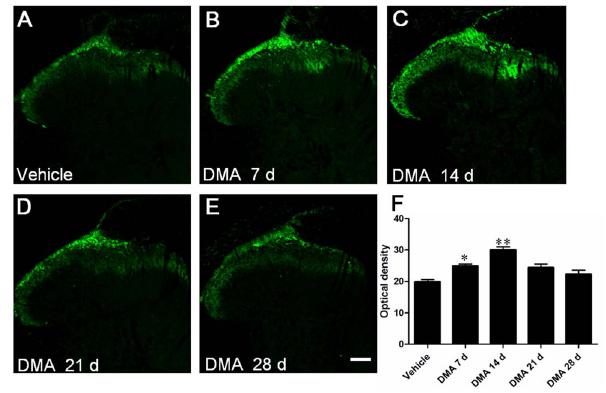
Figure 4. Immunofluorescent staining of TRPV1 in spinal dorsal horn (SDH) with the progression of DMA. A–E , representative photographs of TRPV1 staining in SDH in vehicle, DMA 7 d, 14 d, 21 d and 28 d groups. F , optical density analysis of TRPV1 staining in SDH showing the increased TRPV1-IR neurons on DMA 7 d and 14 d group (n=4–6). Scale bar =100 m m.